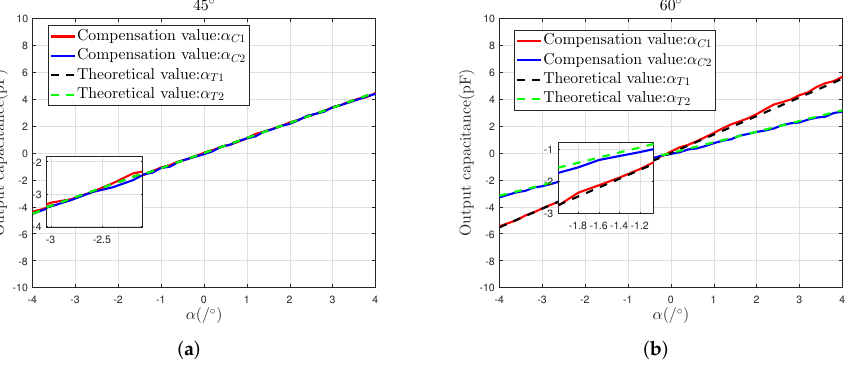
Figure 11. Compensated results: ( a ) the compensated results in the direction of 45 ◦ , ( b ) the compen- sated results in the direction of 60 ◦ .